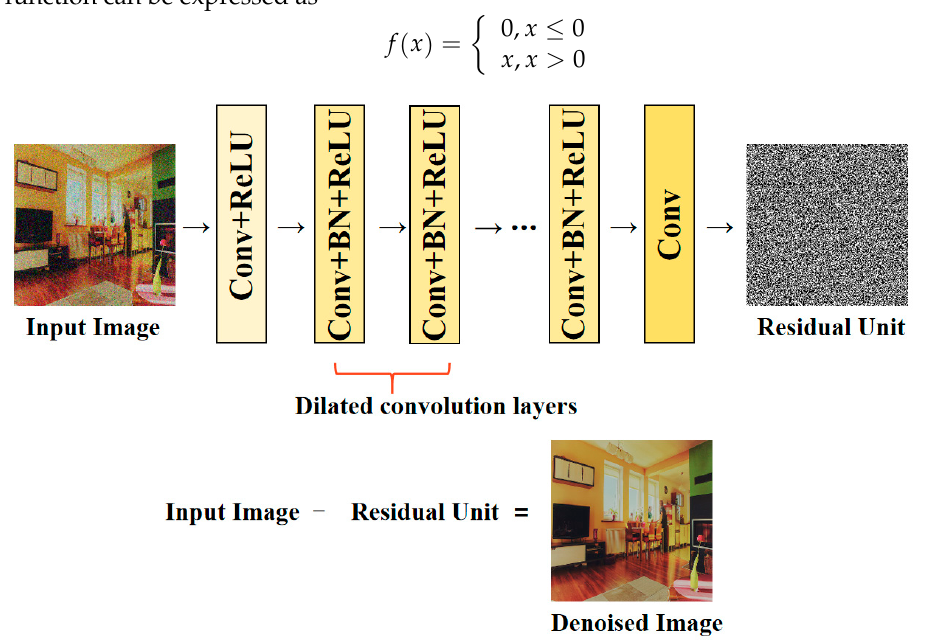
Figure 2. Network architecture in the pre-trained model.